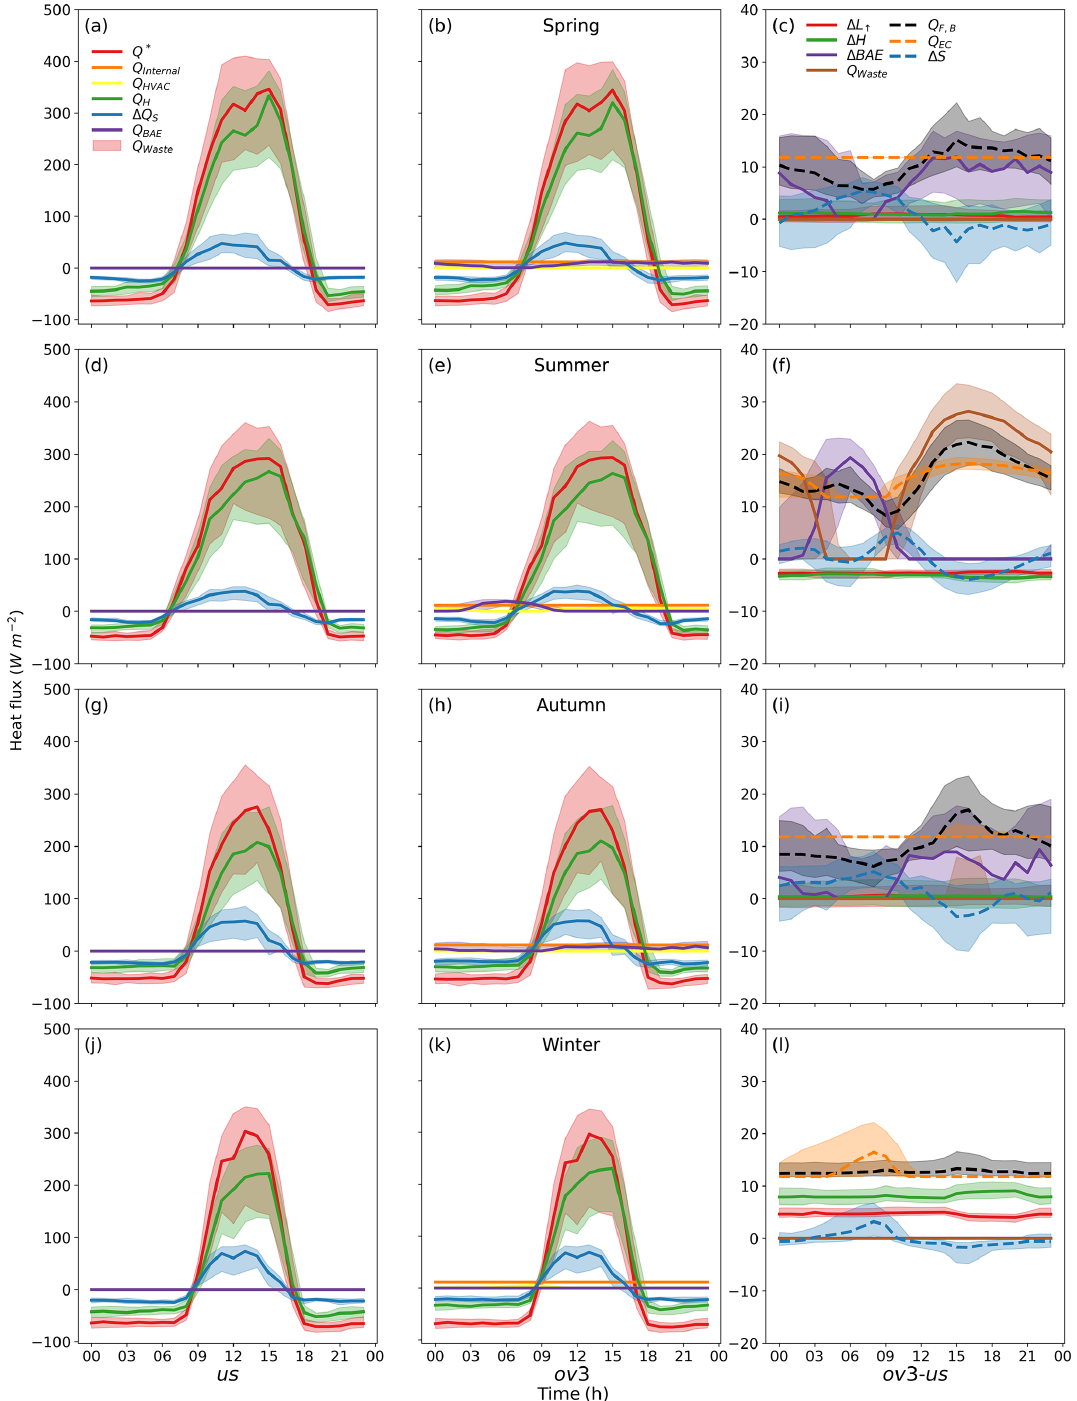
Figure 1. Seasonal diurnal median (line) and interquartile range (IQR, shading) building heat fluxes for (a, d, g, j) unoccupied sealed (us), (b, e, h, k) occupied ventilated (ov 3 ) building and their (c, f, i, l) difference (ov 3 –us) for (a–c) spring, (d–f) summer, (g–i) autumn and (j– l) winter. Q F , B is estimated by either heat transfer difference (solid line components): Q F , B = (cid:49)L ↑ o-uo + (cid:49)H o-uo + (cid:49) BAE o-uo + Q Waste, o in Eq. (14) or energy consumption and storage flux difference: Q F , B = Q EC − (cid:49)S o-uo (dashed line components) in Eq. (15)